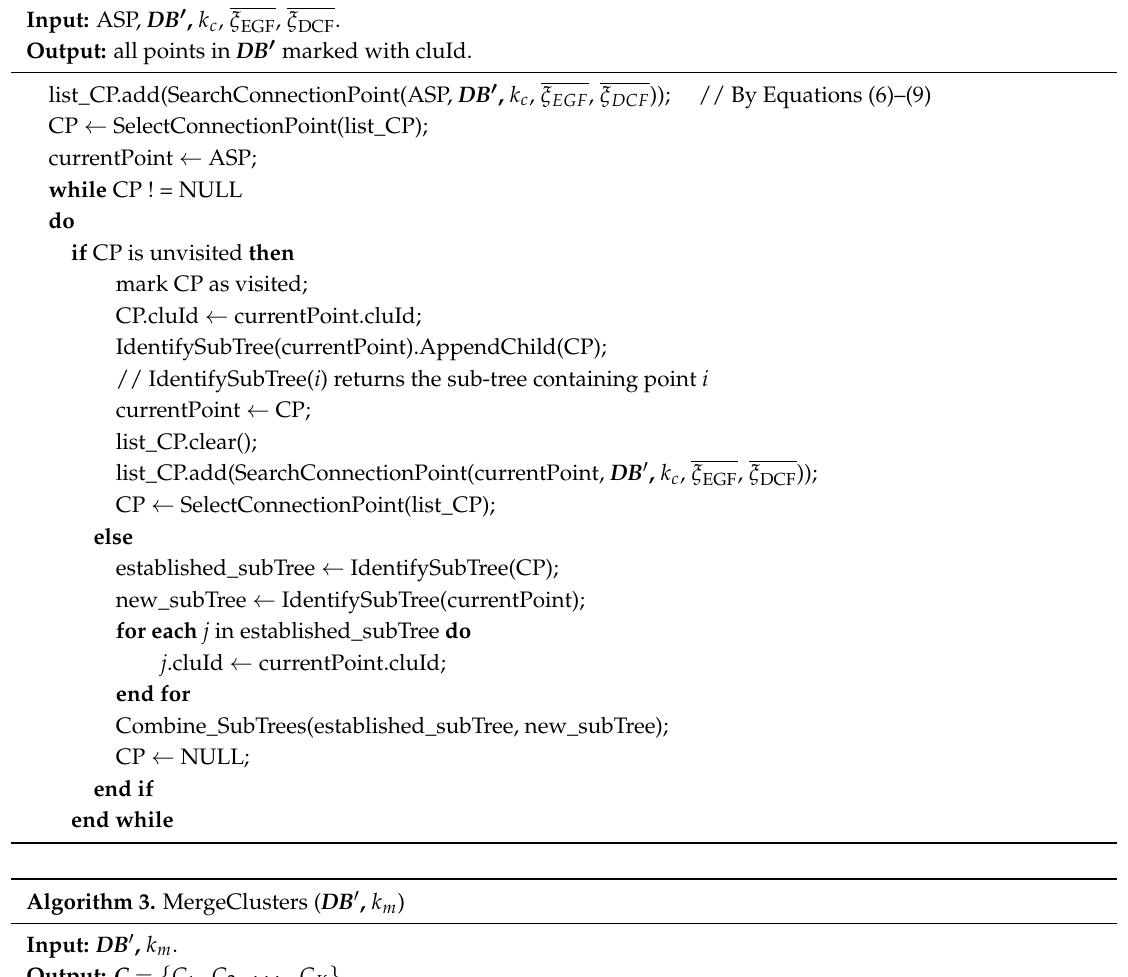
Algorithm 3. MergeClusters ( DB (cid:48) , k m